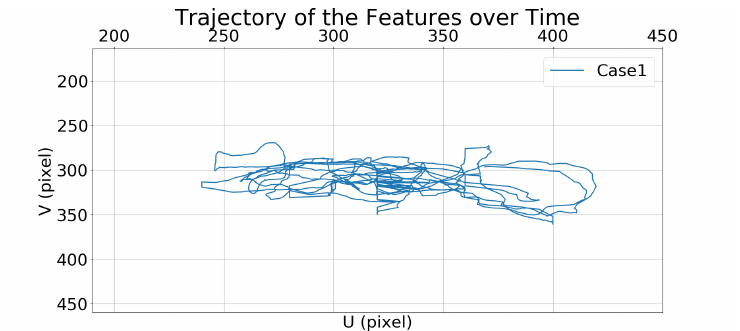
Figure 15. Simulation 2: trajectory of the moving target in the image frame for Case 1.